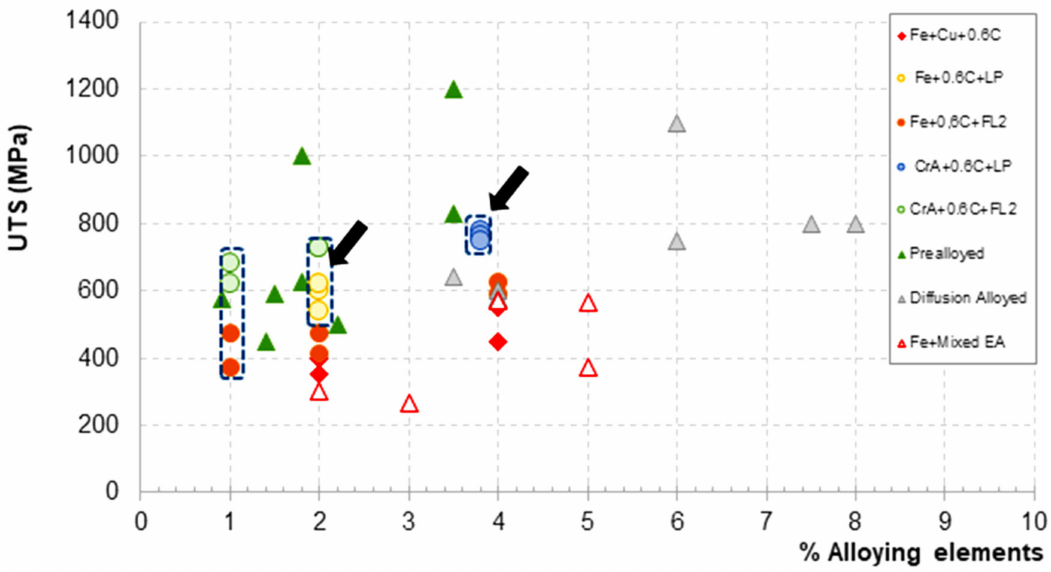
Figure 18. Ultimate tensile strength (UTS) versus % alloy elements (without carbon addition) for various commercial sintered steels [1] and for the modified steels of this